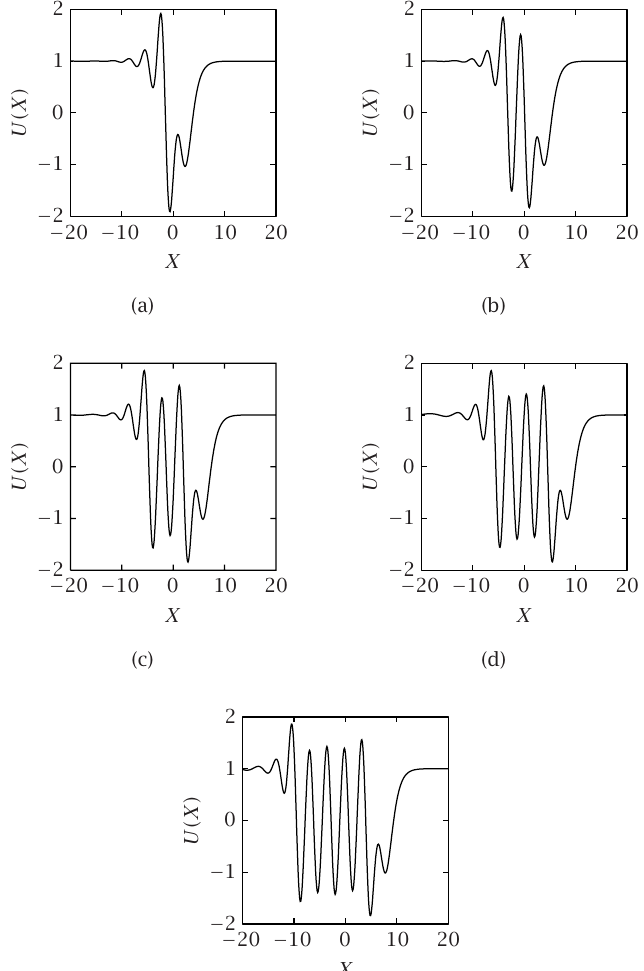
Figure 3.4 . Numerical solutions for the second family of solitary waves: (a) γ = 0 . 12410820, (b) γ = 0 . 11737594, (c) γ = 0 . 11839452, (d) γ = 0 . 11824886, (e) γ = 0 .